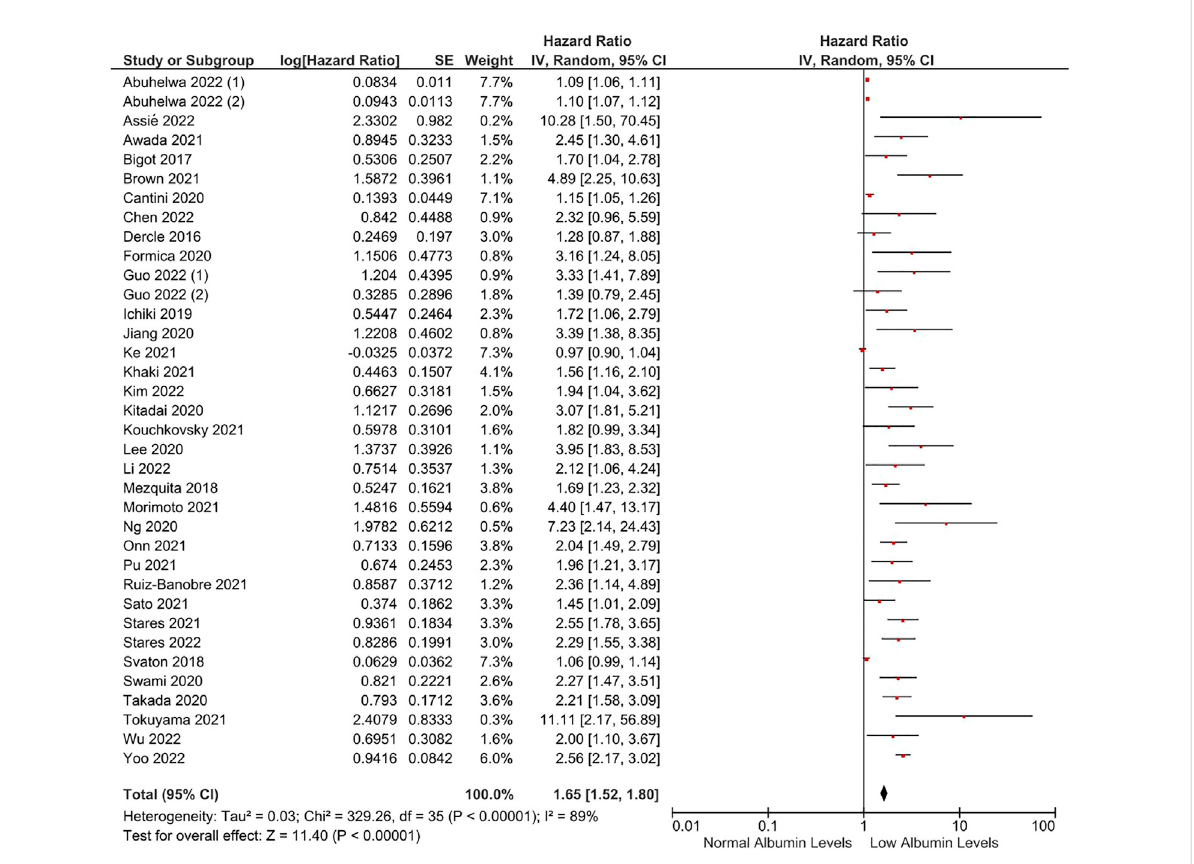
FIGURE 1 The association between albumin levels and OS. Lines ( ○ ) indicate 95% CIs. Diamond ( ◆ ) indicates the pooled effect